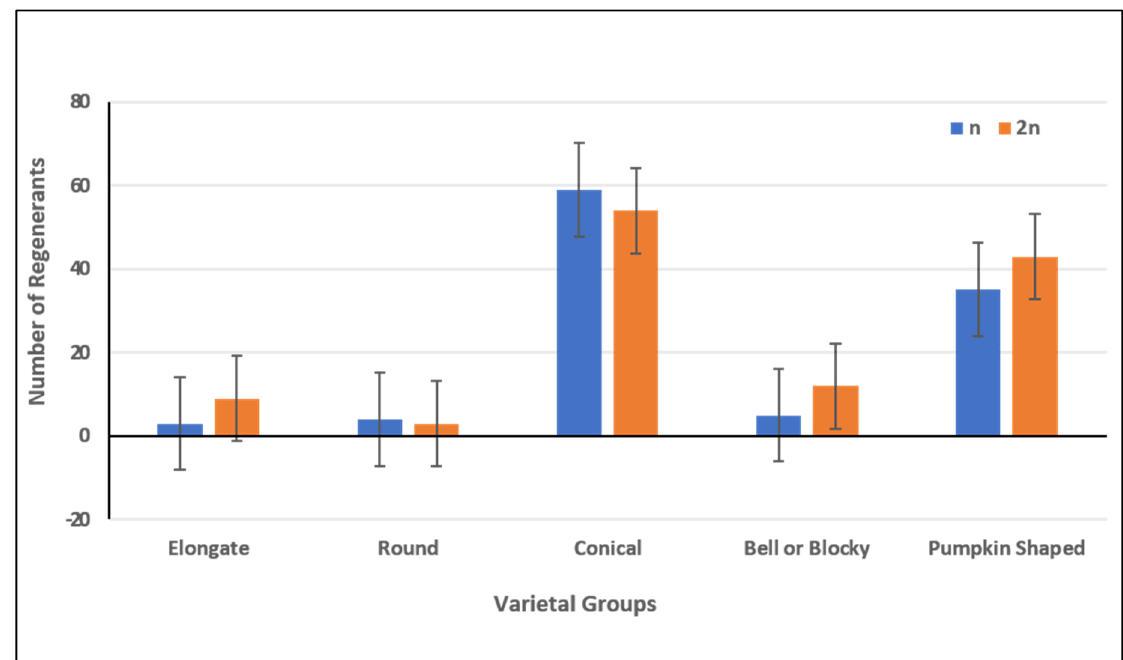
Figure 5. Number of plant-regenerants with different haploid and diploid chromosome levels. Three doubled haploid and five haploid regenerants were used for counting the number of chloroplasts in stomata cells. In haploids, the number of chloroplast grains was between four to six per cell for all tested varietal types, while for doubled haploid individuals this number ranged between seven to nine per cell. Visual observation of plant habitus and leaf size were not always informative regarding the chromosome sets. In some cases, regenerants with dwarf habitus were able to produce seeds, which was one of the best criteria indicating individuals with two identical chromosome sets (Figure 6).